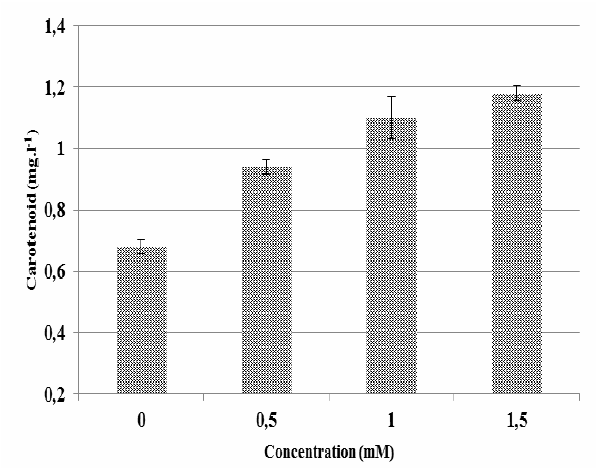
Fig. 5. Effect of different concentrations of SA on carotenoid